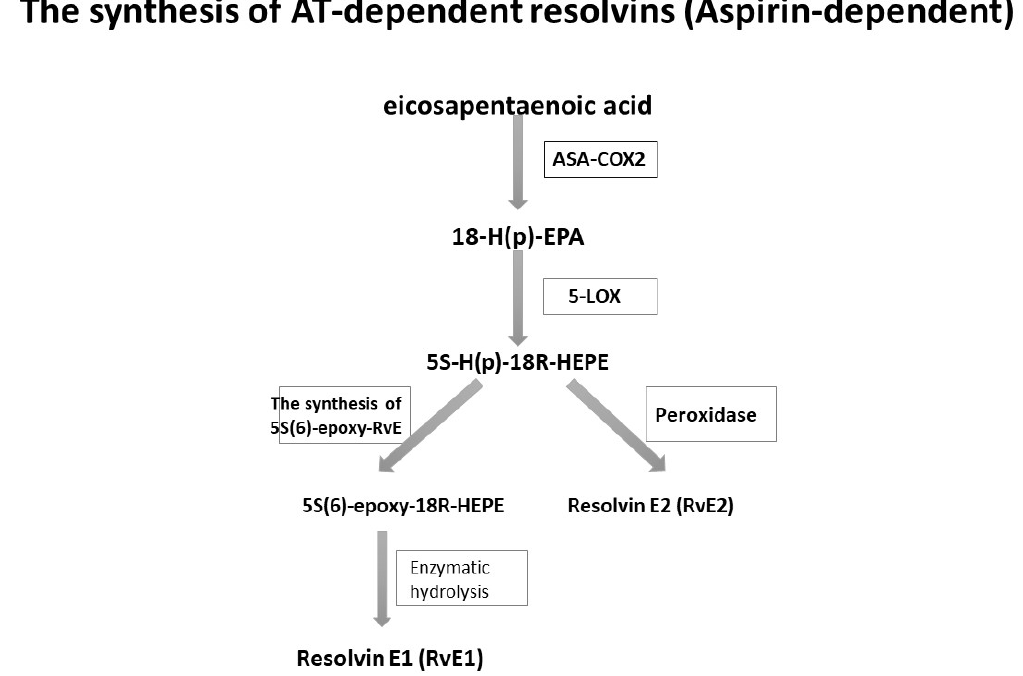
Figure 2. The biosynthesis of resolvins E with the participation of ASA [38,39].